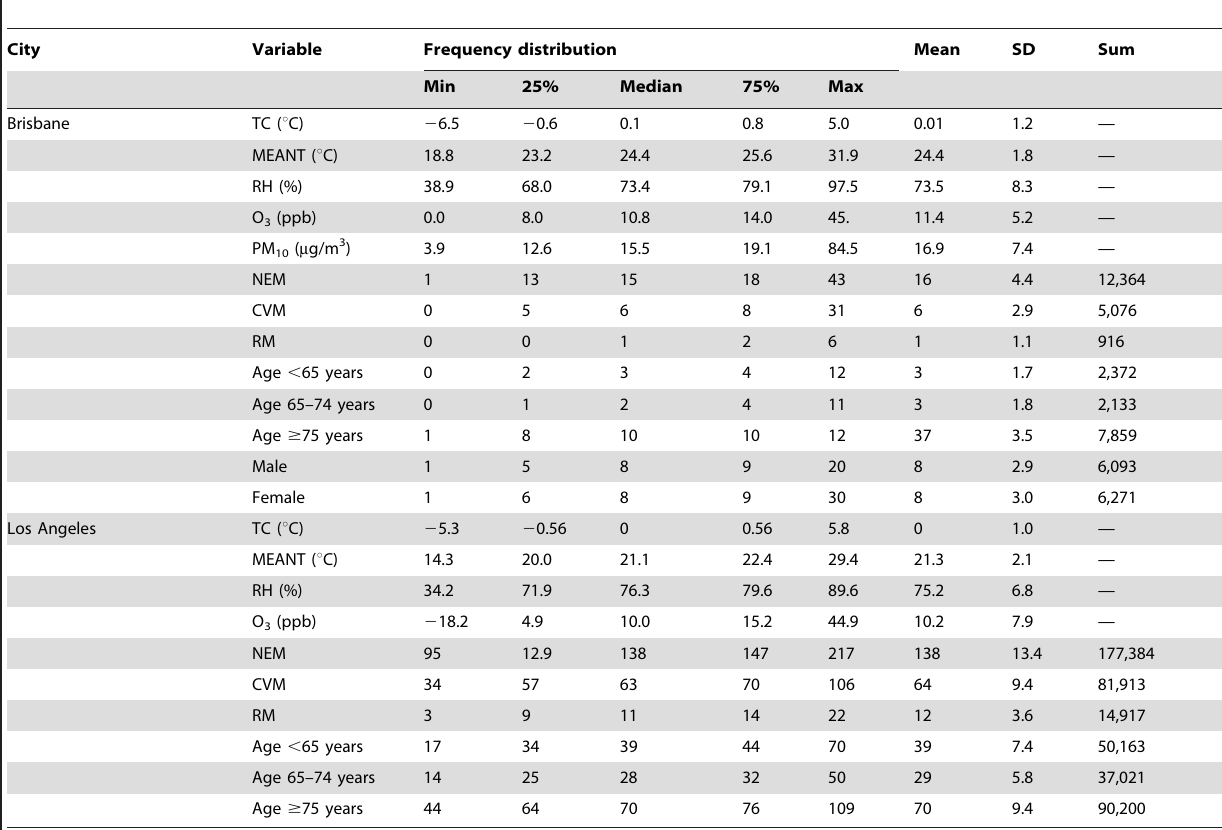
Table 1. Summary statistics for daily weather conditions, air pollutants, and mortality in Brisbane, Australia and Los Angeles, United States.